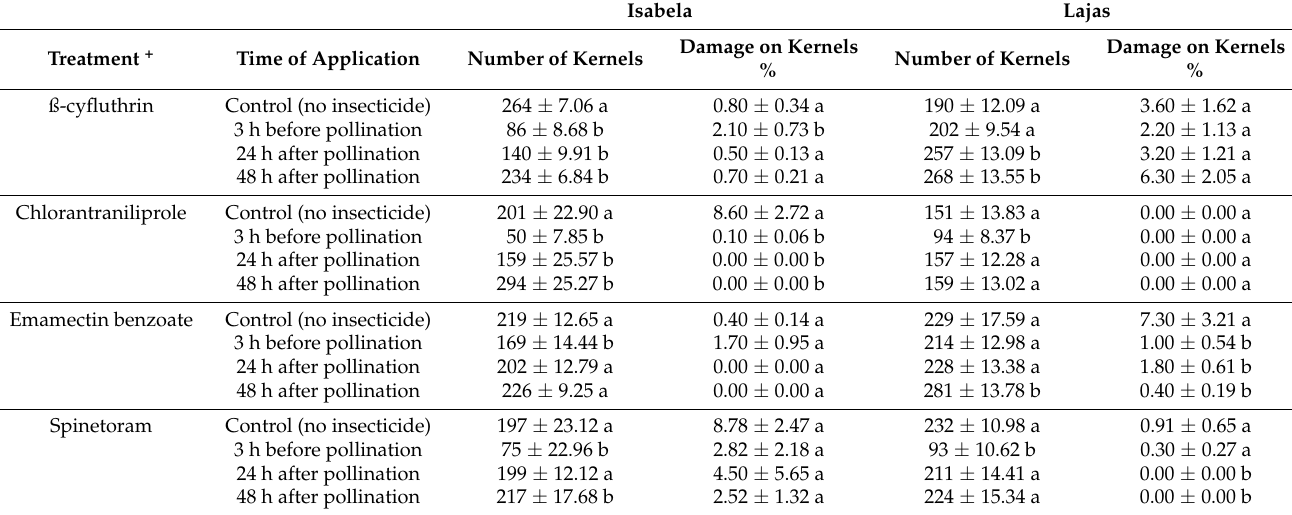
Table 7. Mean ( ± SE) of the number of kernels produced at different time of insecticide applications and percentages of damage of corn earworm ( Helicoverpa zea (Boddie) (Lepidoptera: Noctuidae)) and fall armyworm ( Spodoptera frugiperda (J. E. Smith) (Lepidoptera: Noctuidae)) larvae in kernels of sweet corn ( Zea mays L.) ‘Suresweet 2011 (cid:48) planted at Isabela and Lajas, Puerto Rico in 2020 and 2021. Isabela Lajas